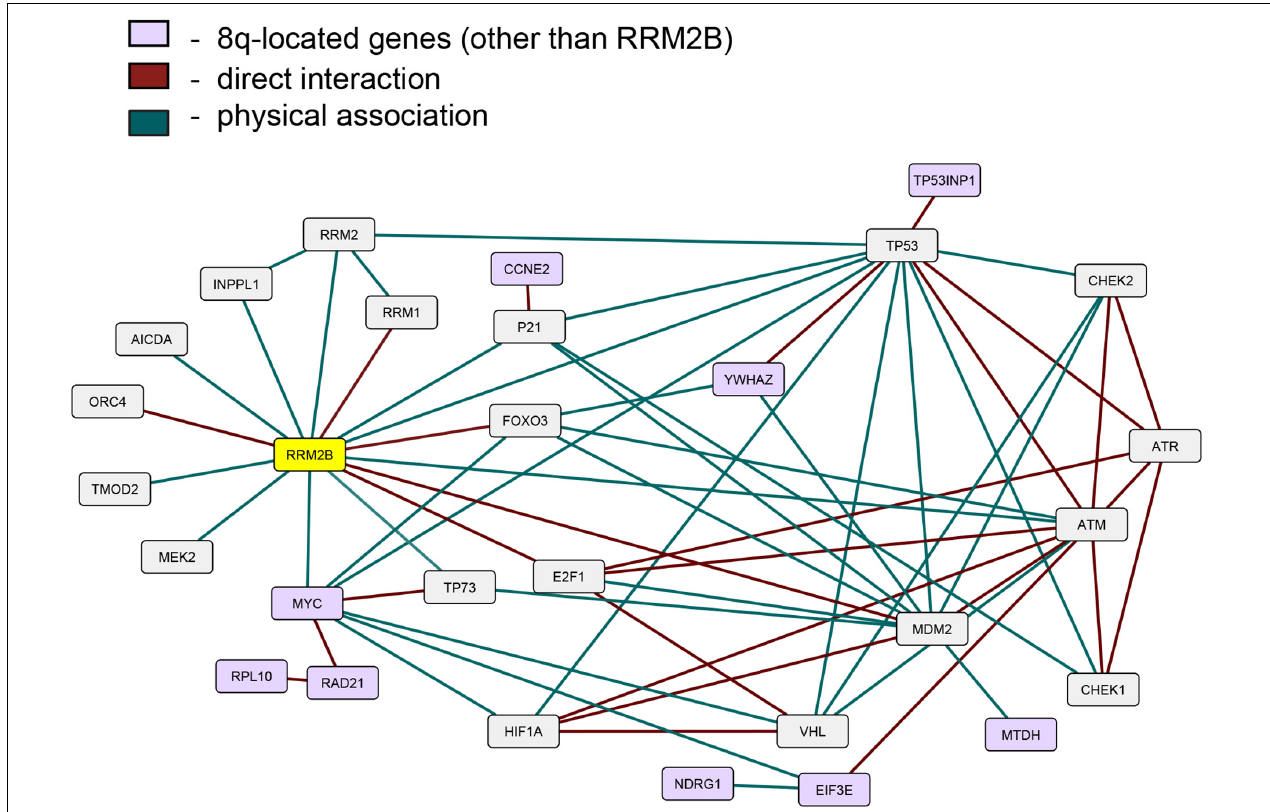
FIGURE 4 | An interactive network of RRM2B and related genes. The network represents proteins that functionally interact or intersect with RRM2B (yellow) or other 8q-gene products (purple). Red lines represent direct interaction, and green lines—physical association (interactions classified according to the BioGRID database